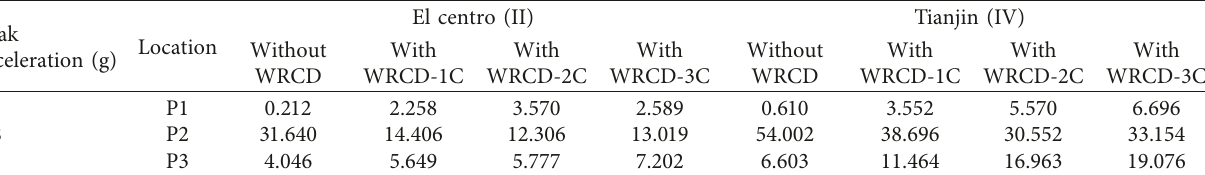
Table 3: Maximum displacement for different frequency spectra (cm).